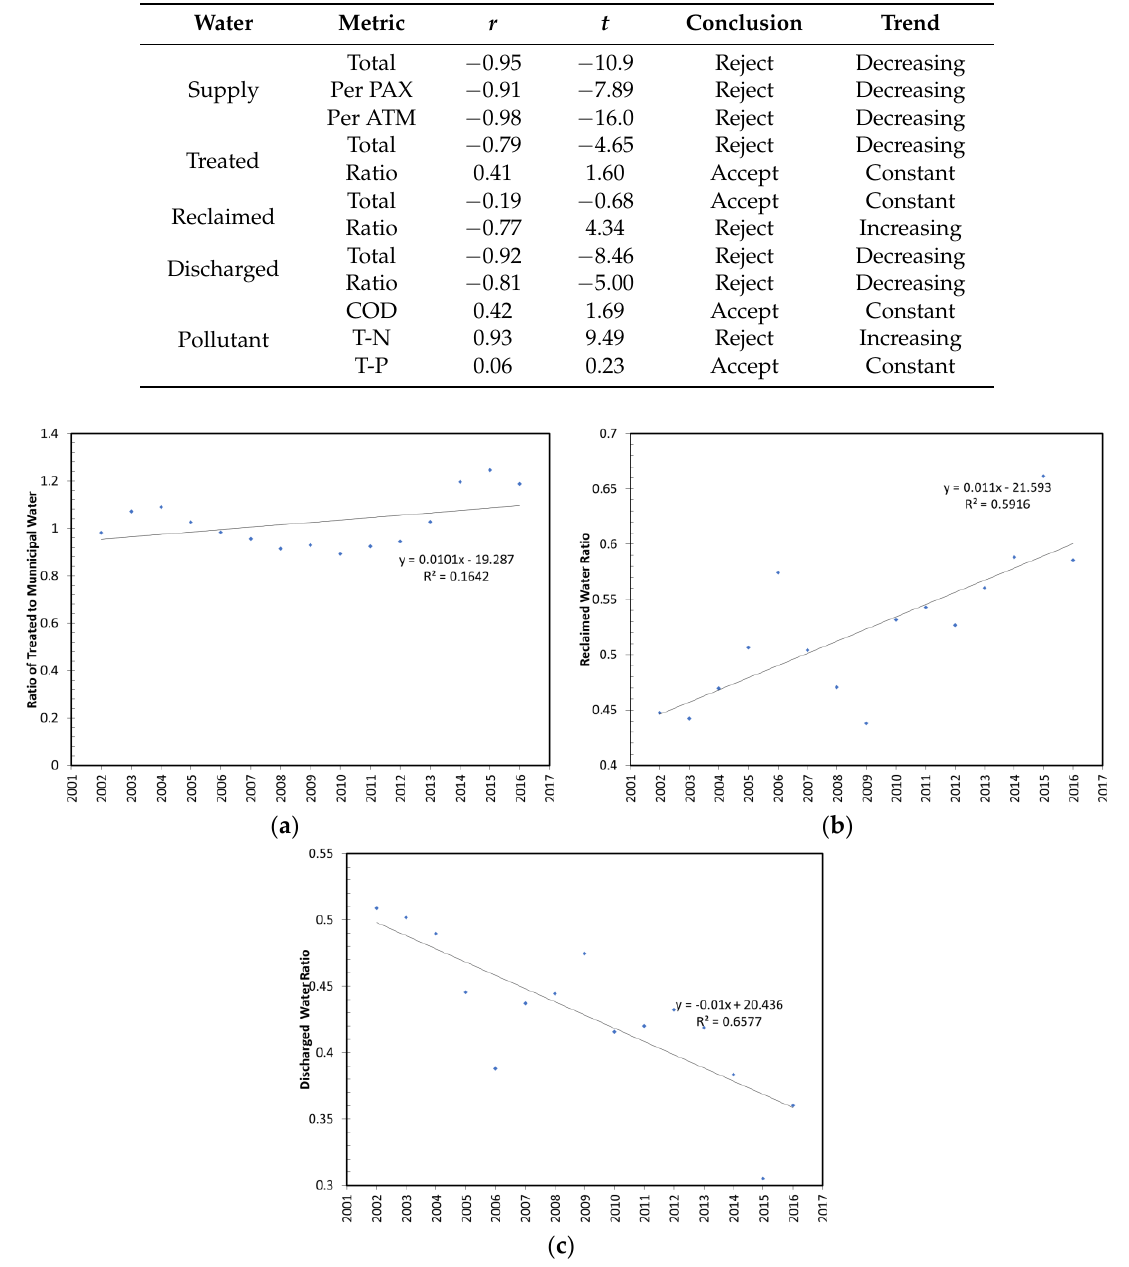
Table 2. The correlation assessment of water parameters for various metrics, all testing at the 95% confidence level, with 12 degrees of freedom, using a one-tailed test, with t crit = 1.77.